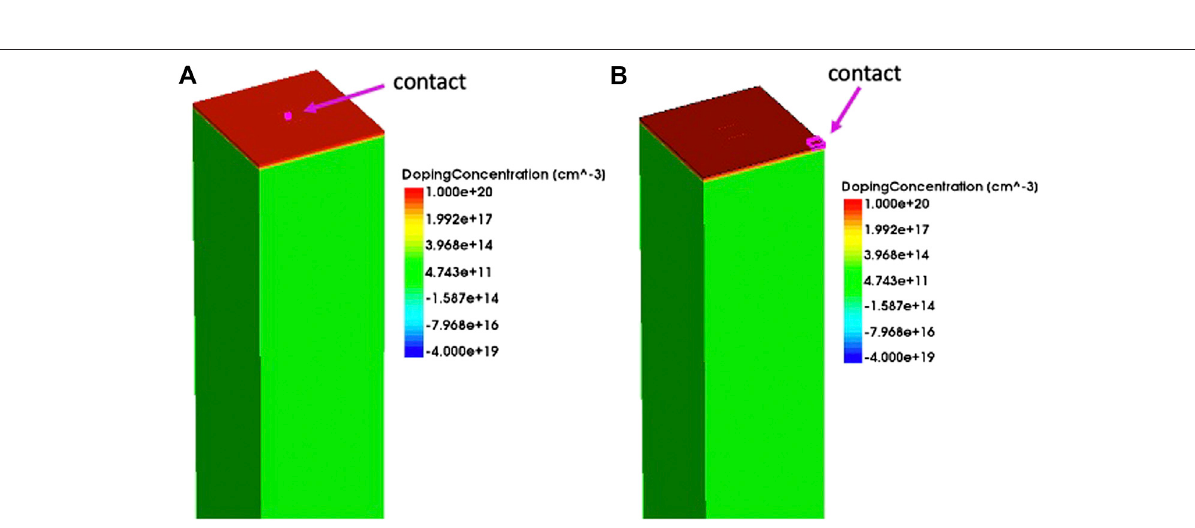
Frontiers in Physics |